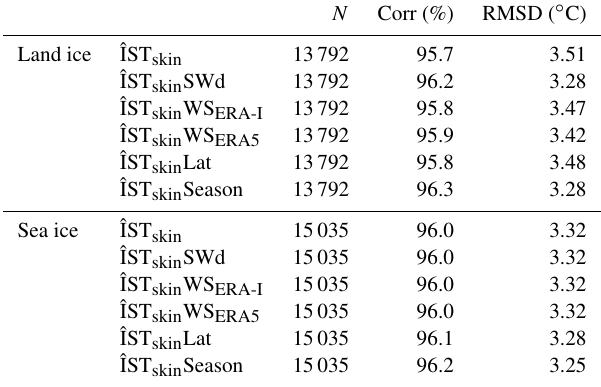
Table 3. Statistics on the relation between observed and modelled temperatures for the training data. N : number of matchups used for testing; Corr: correlation; RMSD: root-mean-square difference. Since, the training data are used for the regression, the bias is zero, and thus the standard deviation equals